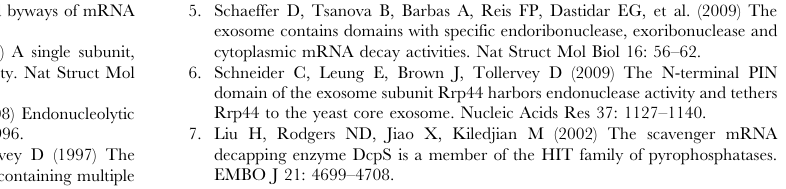
Figure S1 A. Superimposition of the five ScPat1C structures (each ScPat1C structure is shown with a different color). The rmsd values range from from 0.3 A˚ to 1.2 A˚ over 260-310 C a atoms. B.